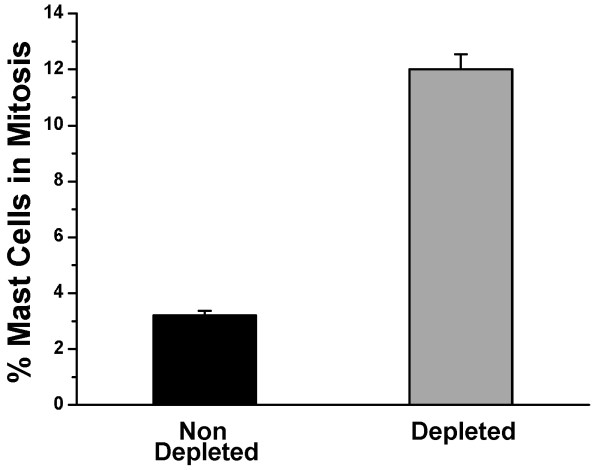
Forty eight hours after mast cell depletion of the peritoneal cavity, there is a greater number of MCp in mitosis . The peritoneal lavage was collected from rats depleted or non-depleted of mast cells by distilled water injection. The total cell population was double immunostained with both anti-phospho-histone H3 and mAb AA4 in order to identify mast cells in mitosis. The average of 3 independent experiments ± SD is shown.